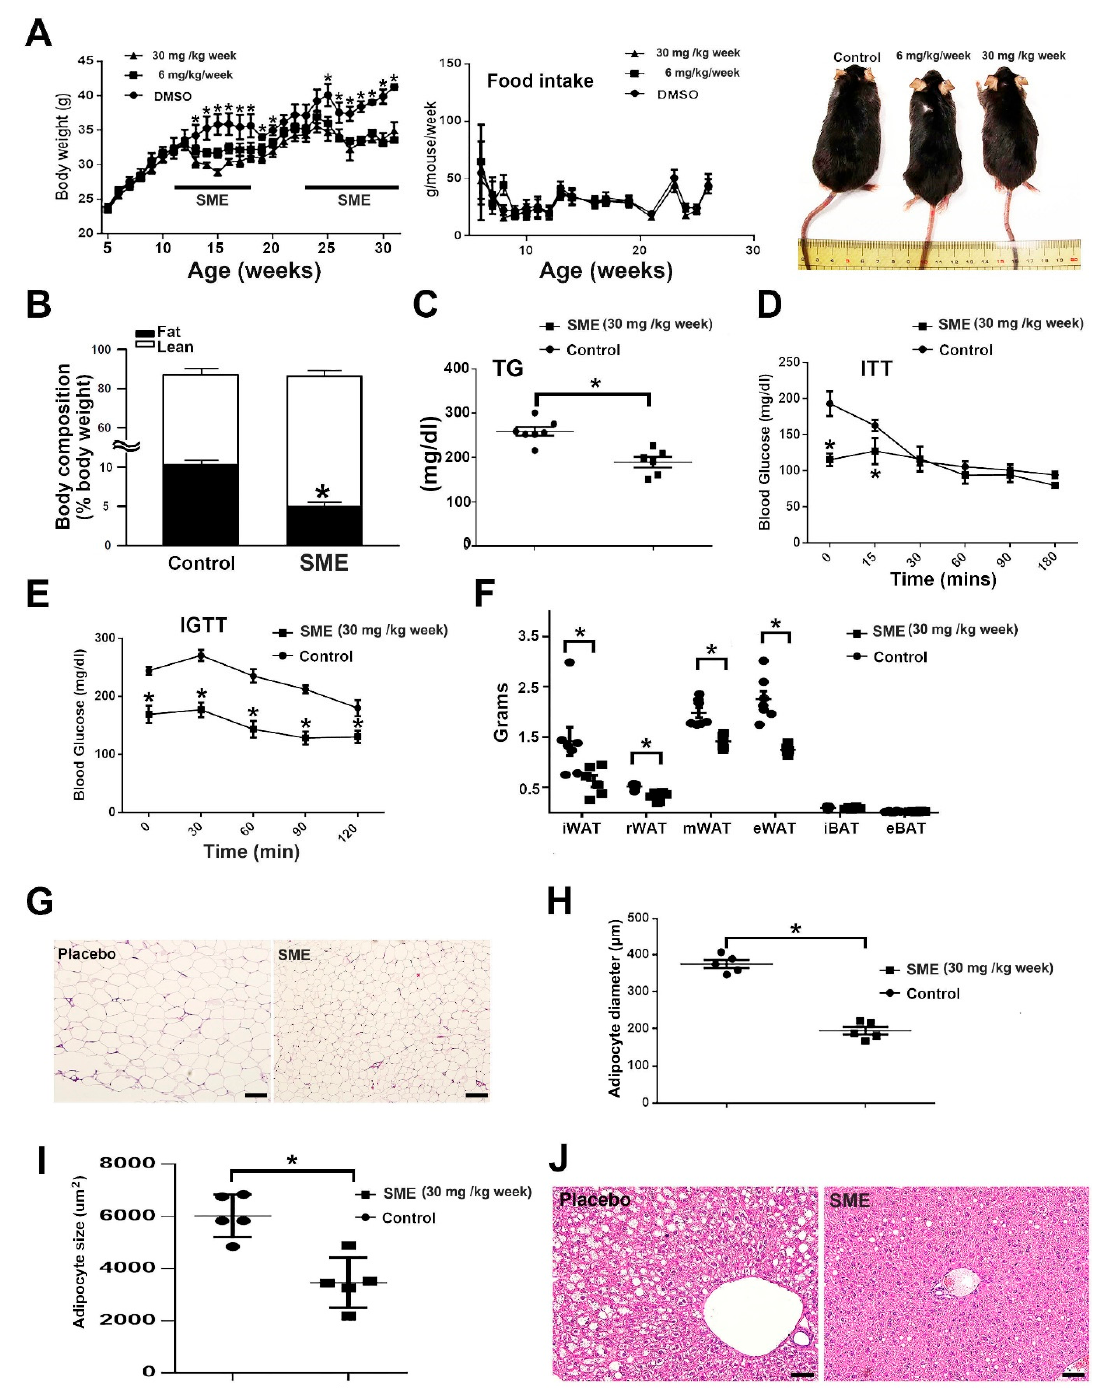
Figure 1. Results of treatment with or without Salvia miltiorrhiza extract (SME) in wild-type (WT) mice with high-fat-diet (HFD)-induced obesity and metabolic dysfunction. ( A ) Body weight, food intake measurements, and body imaging for placebo and SME treatment groups. ( B ) Body composition analysis. ( C ) Serum triglyceride (TG) levels. ( D ) Insulin tolerance test results. ( E ) Glucose tolerance test results. ( F ) Weights of inguinal WAT (iWAT), retroperitoneal WAT (rWAT), mesenteric WAT (mWAT), epididymal WAT (eWAT), interscapular BAT (iBAT), and epididymal BAT (eBAT). ( G ) Representative photographs of hematoxylin and eosin ( H , E ) staining results for iWAT. ( H ) Adipocyte diameter ( µ m). ( I ) Adipocyte size ( µ m 2 ). ( J ) Liver ( H , E ) staining results. Data are the mean ± SEM; * p < 0.05 compared with control. For ( A – F ), n = 7 per group; for ( H , I ), n = 5 per group. Scale bar = 50 µ